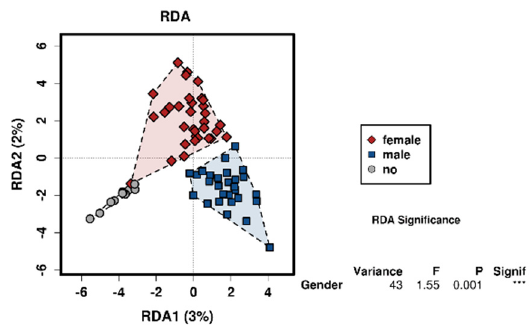
Figure 5. Redundancy analysis (RDA) plot of female and male participants. “No” (grey) indicates the controls. The figure shows significant differences between the sexes. Female, male, and controls are clustering separately. The overlapping of controls with a female sample indicates a low number of reads in the female sample.